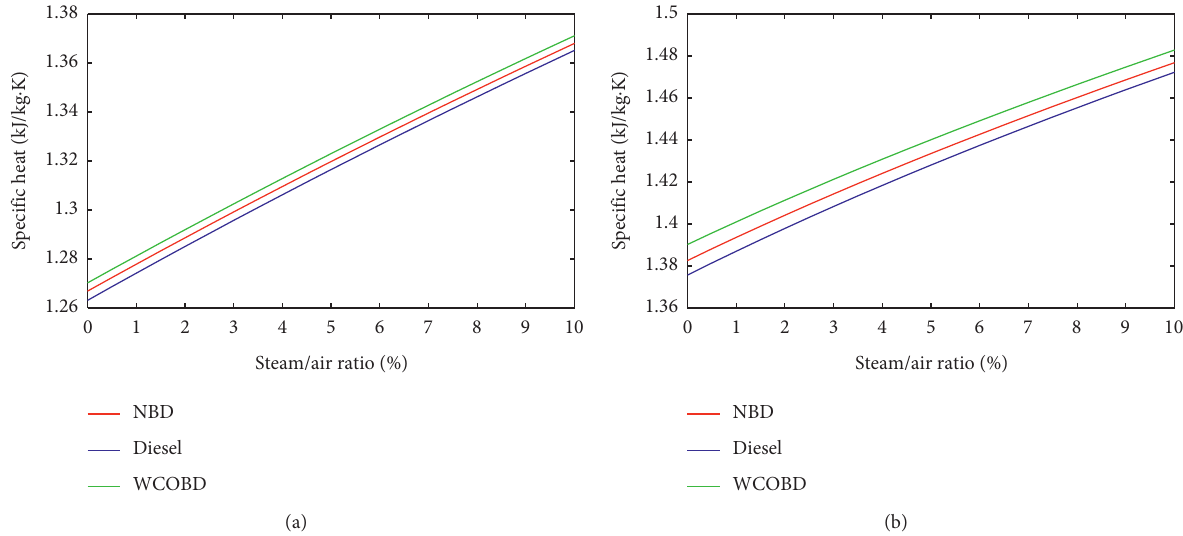
Figure 11: Variation of gas mixture specific heat with steam injection ratios.